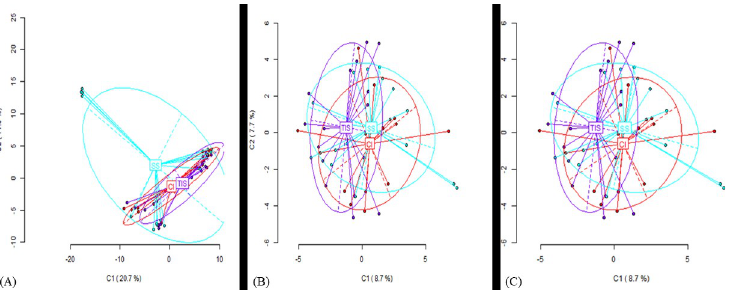
Fig 3. PCoA for Musa plants. (A) PCoA Mse I for Musa field plants. CI, Complete Immersion; TIS, Temporary Immersion System; SS, Semi-Solid, (B) PCoA on MSL for Musa field plants CI: Complete Immersion, TIS: Temporary Immersion System, SS: Semi-Solid, (C) PCoA on NML for Musa field plants CI: Complete Immersion, TIS: Temporary Immersion System, SS: Semi-Solid.